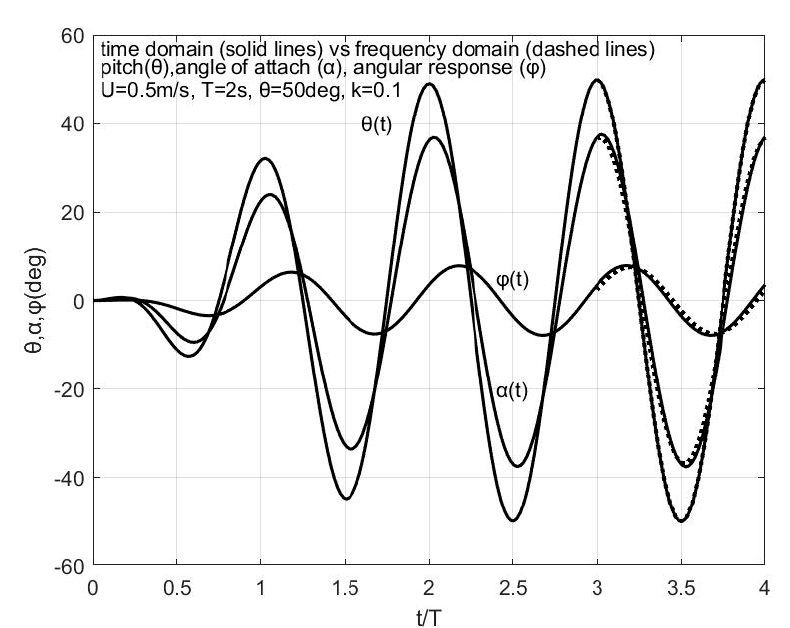
Figure 11. Response of the system and effective angle of attack, against prescribed angle of self-pitching motion of the foil, as a function of time for flow speed U = 0.5 m/s, reduced frequency k = 0.1, pitching amplitude θ 0 = 50 ◦ and dimensionless damping coefficient C (cid:48) = 29.5. The results obtained by time-domain model are indicated using solid lines and those by the linearized frequency domain model with dotted lines.